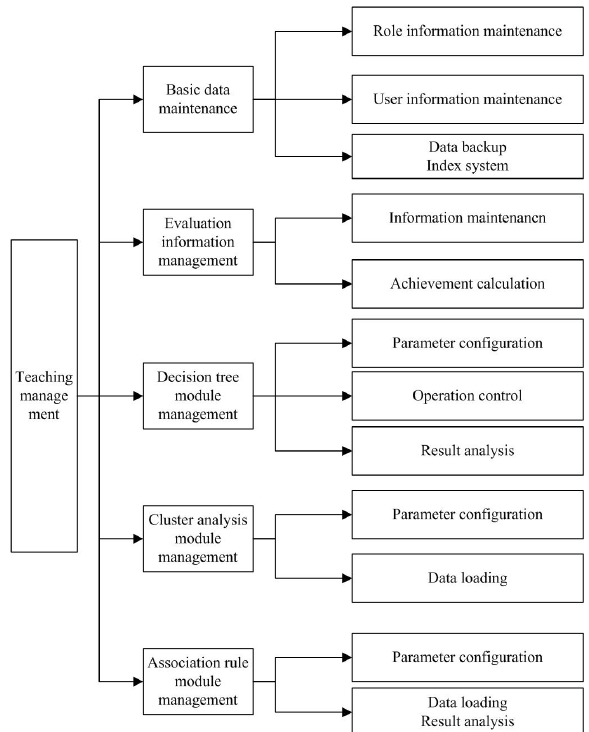
Fig. 1. Structure